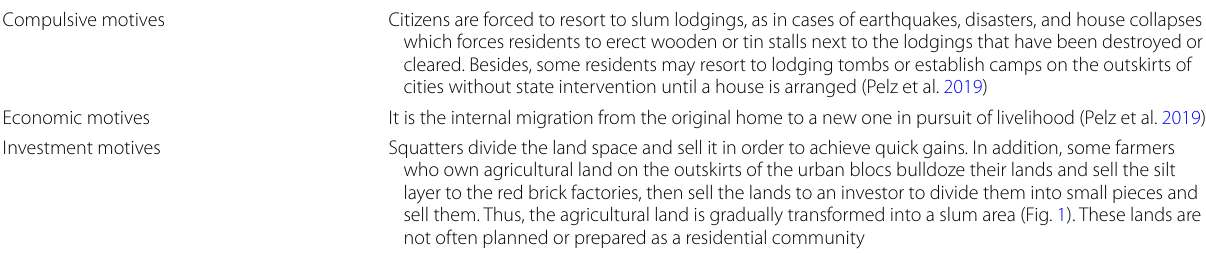
Table 1 Reasons for the emergence of slums Compulsive motives